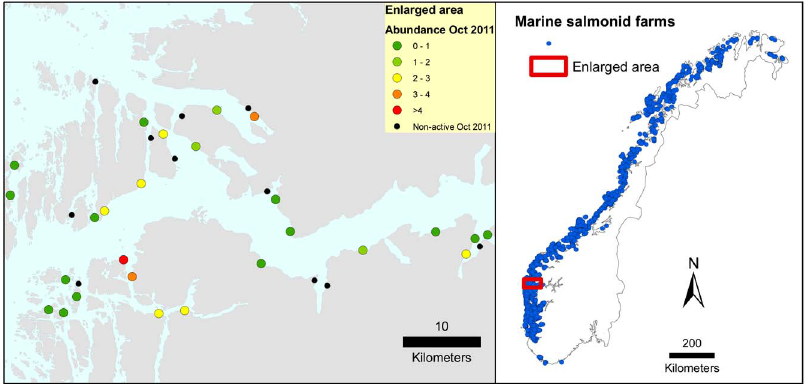
Figure 2. Location of salmonid farms. The left panel shows marine farms in the enlarged Sognefjorden area that were actively producing salmonids between June 2003 and December 2011, with observed salmon lice abundance indicated for those active in October 2011. The right panel shows marine farms that were active in the period June 2003 - December 2011 in the whole of Norway.